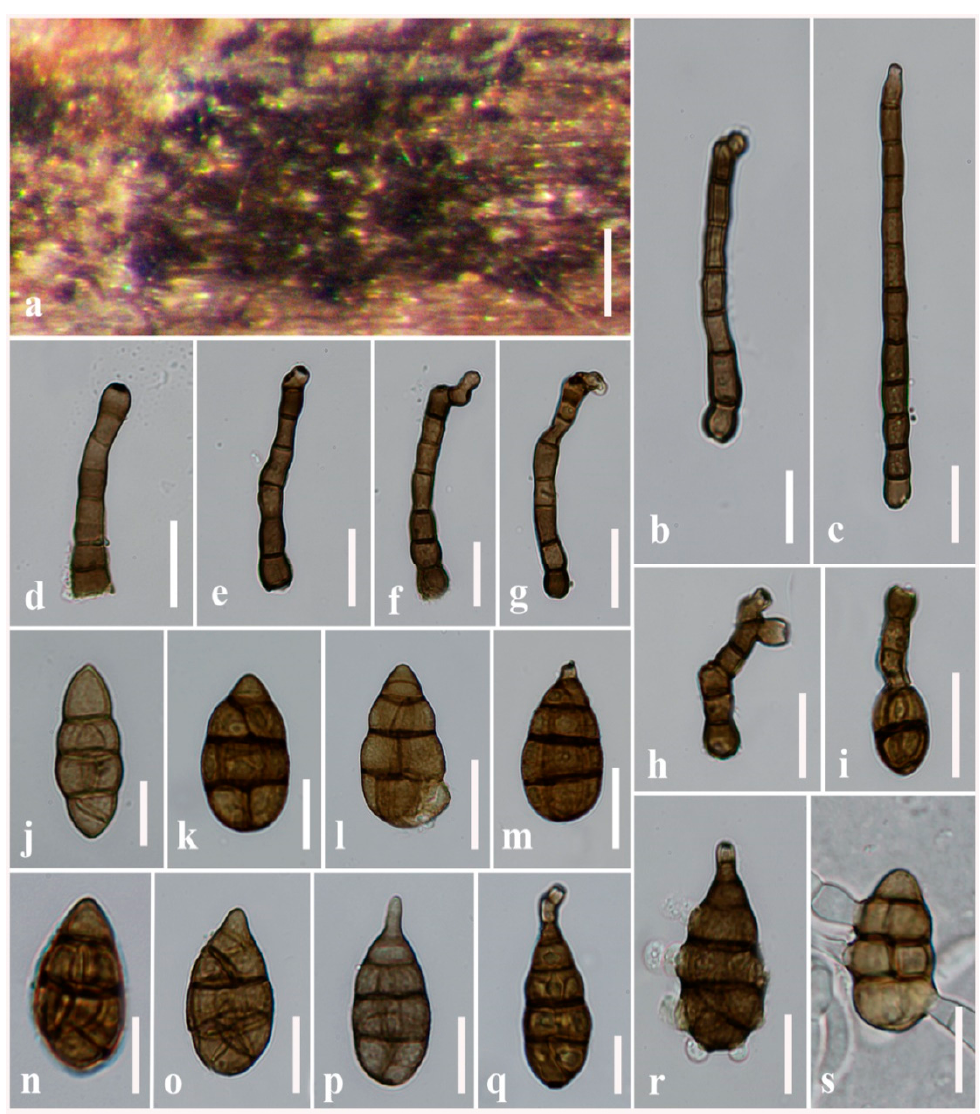
Figure 7. Alternaria torilis (MFLU 21-0299, holotype). ( a ) Colonies on stems of Torilis arvensis ; ( b –